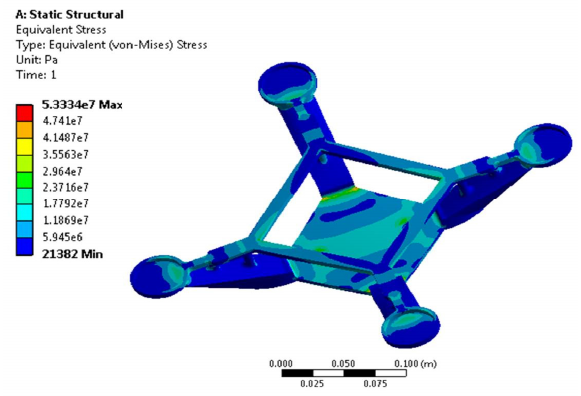
Figure 18. Von-Mises stress induced at 98.8 Hz.